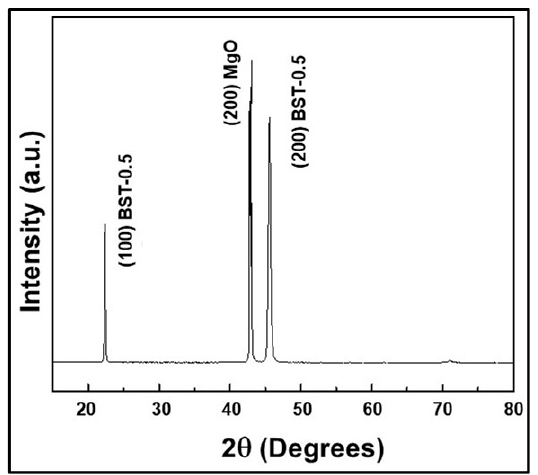
Figure 3. X-ray diffraction (XRD) pattern of BST-0.5 film, under in-plane compression, on single crystal (100) MgO substrate. The peak at 2 θ = 22.36°, the out-of-plane lattice spacing (i.e., d 001 or a ⊥ ) was calculated to be 0.3973 nm, which is higher than the interplanar spacing, d 001 (0.3947 nm), of unconstrained or freestanding cubic BST-0.5 film.